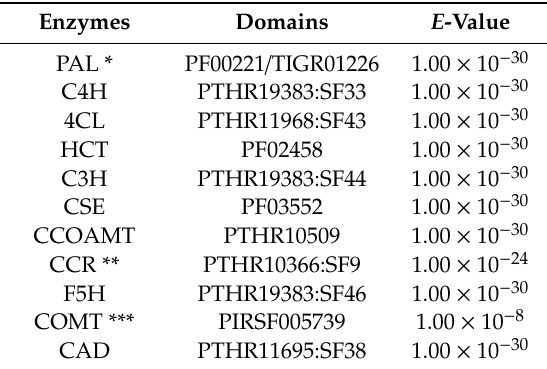
Table 1. Identification of lignin biosynthesis